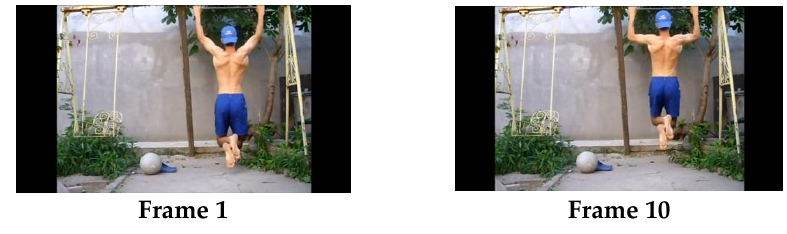
Figure 12. Sample video frames of Action 9 (pull up).